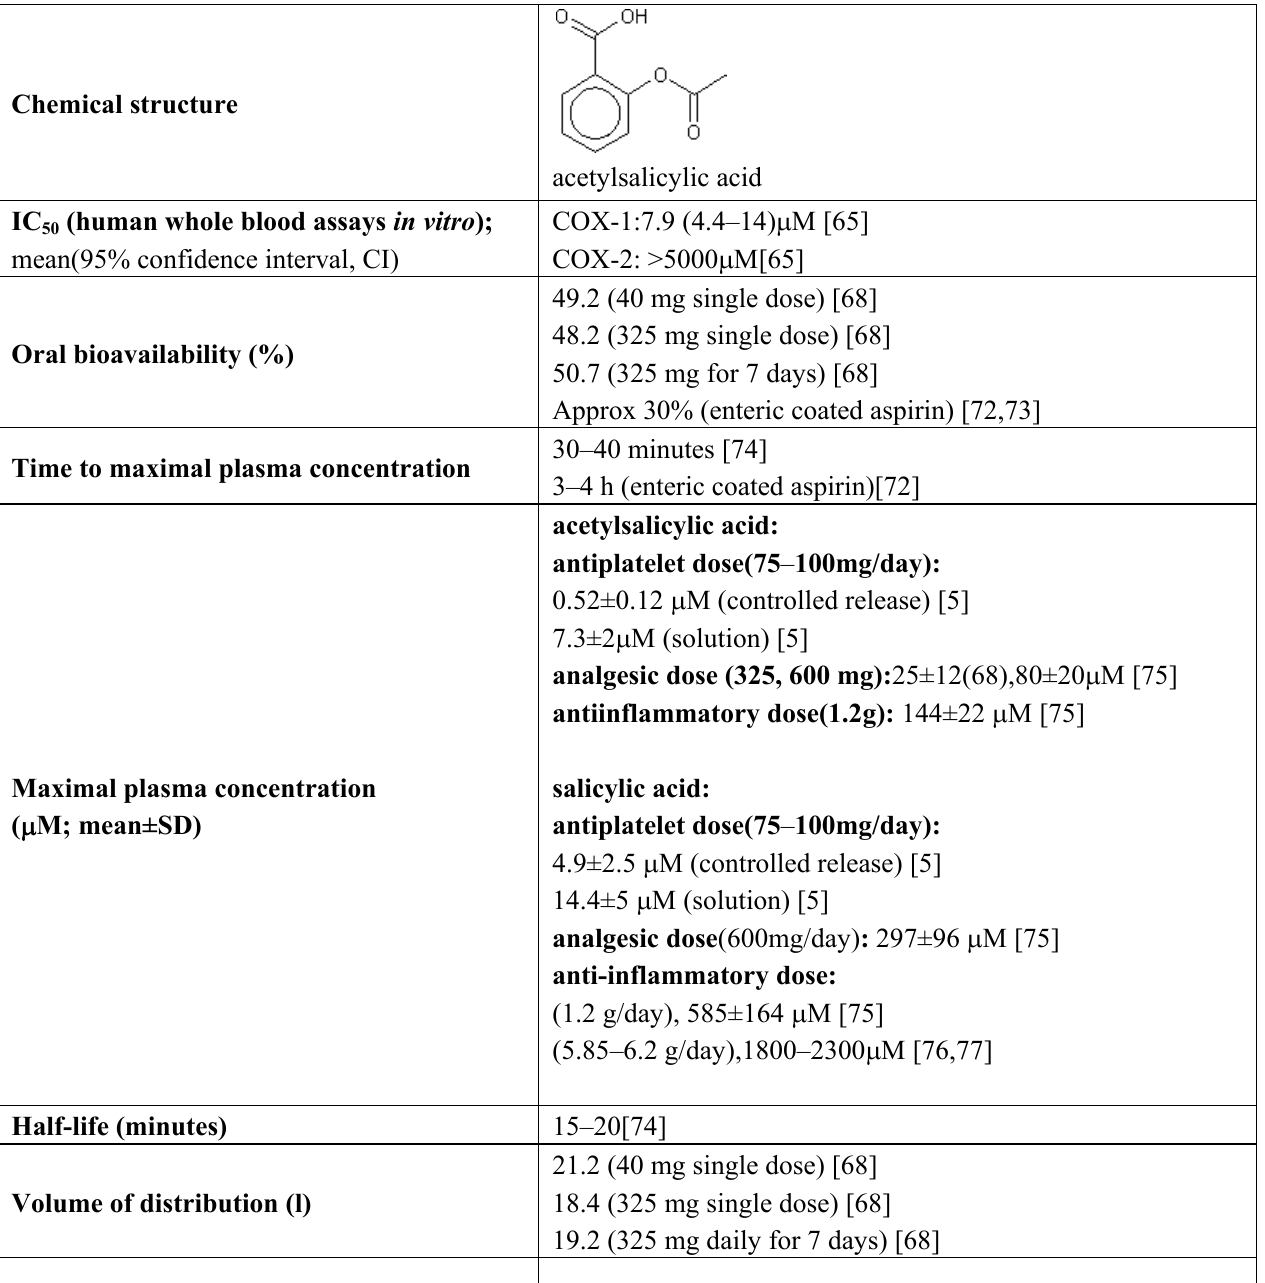
Table 2. Pharmacodynamic and pharmacokinetics characteristics of